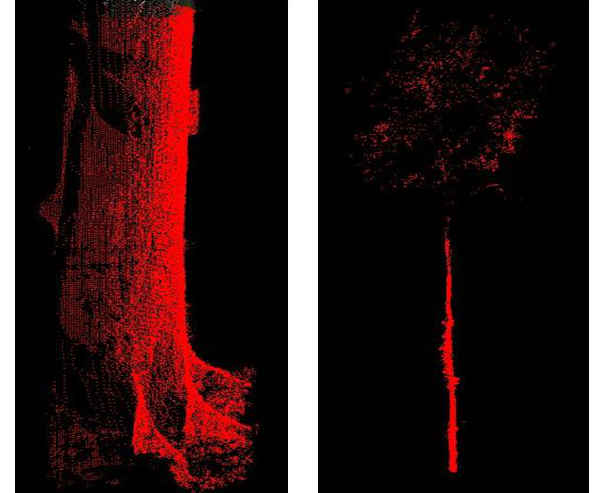
Figure 12. Plot comparison of AGC stocks